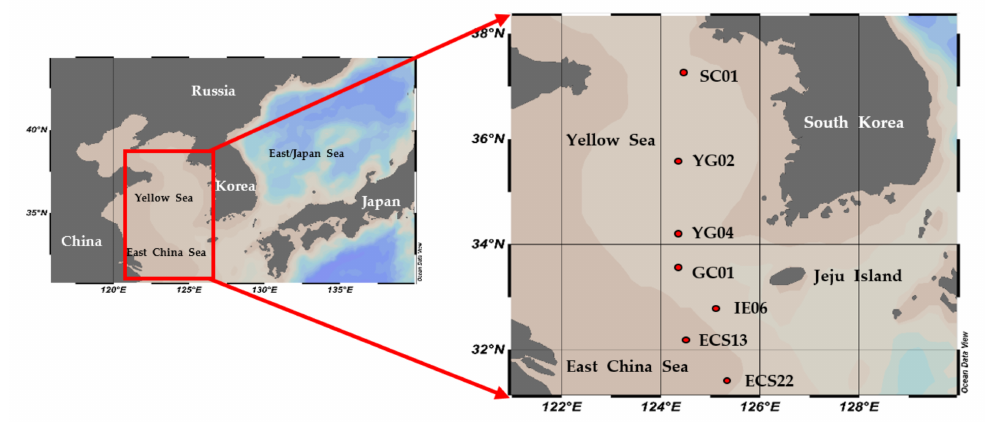
Figure 1. Overview of the study region with water sampling locations in the YS (4 stations) and the ECS (3 stations) during the late summer (9–13 September) of 2020. Table 1. Station information and environmental condition in the YS and the ECS during the late summer of 2020. Region